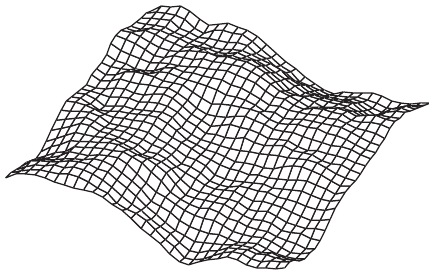
Figure 1: A discrete height map